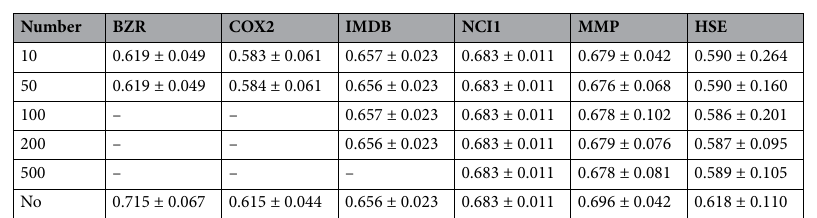
Table 3. AUC values (mean ± std) of different numbers of anomalous graphs in training set.